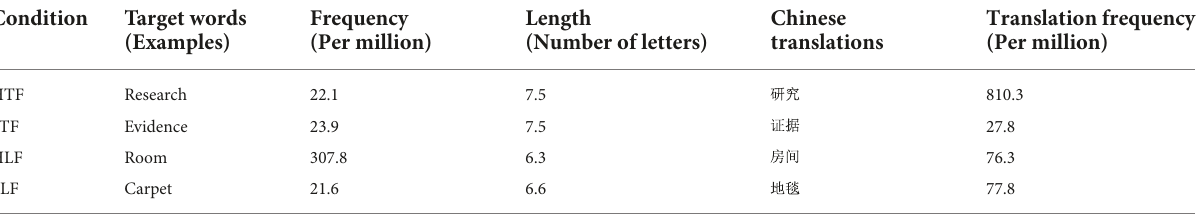
TABLE 3 Conditions (the mean frequency, length, and translation frequency of target words) in the lexical decision task.